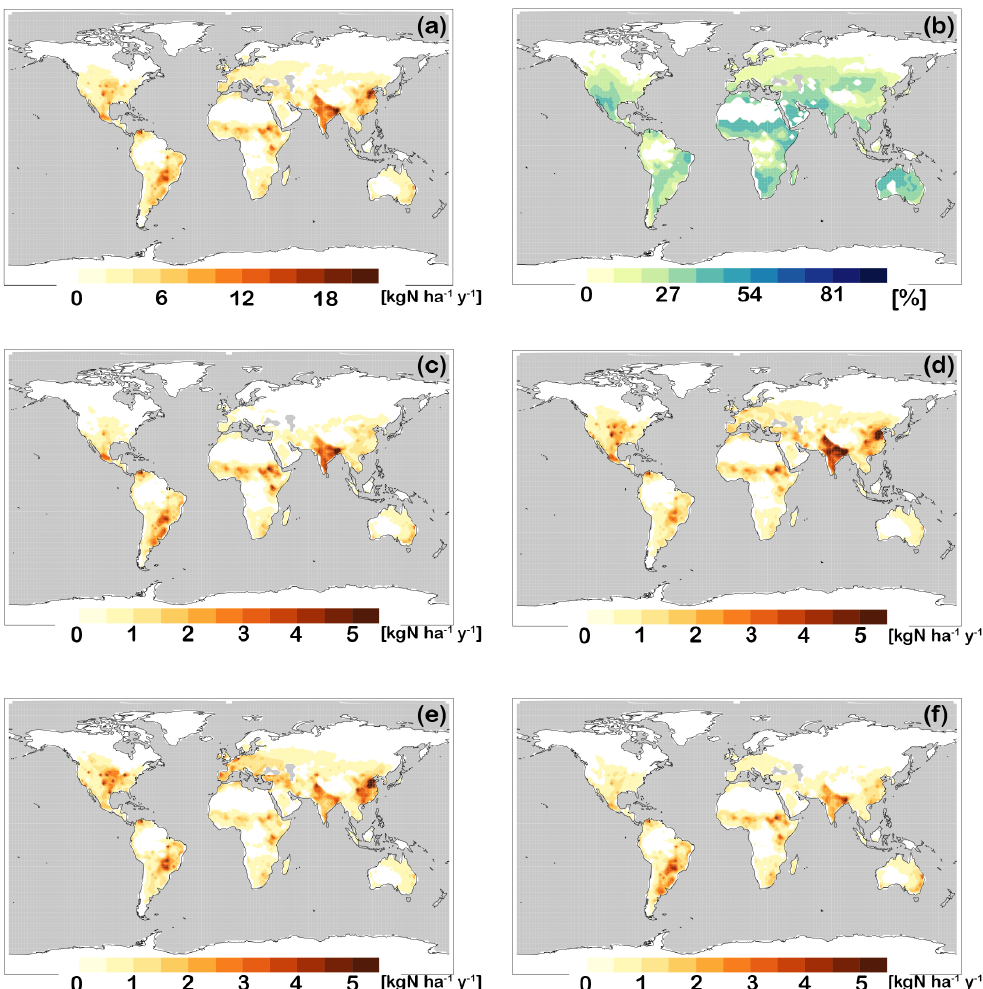
Figure 5. As in Fig. 4 but for manure